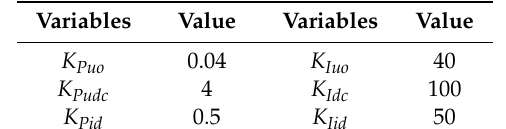
Table 1. Parameters of the solid state transformer controller.